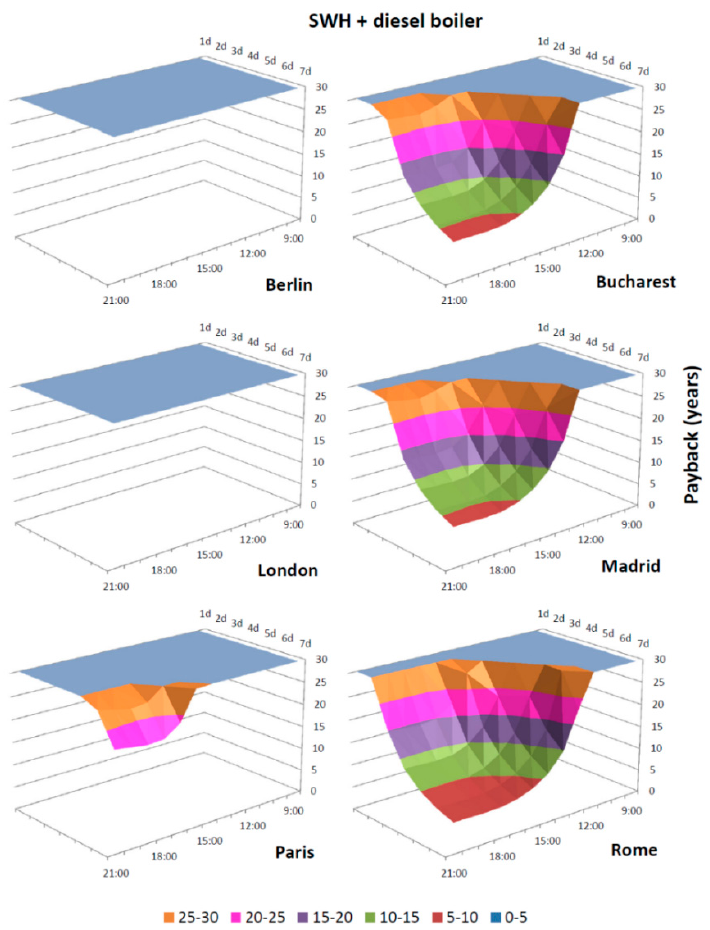
Figure 5. SWH profitability (updated payback) in a facility with a diesel boiler, depending on the time and number of days per week that the hot water is demanded.